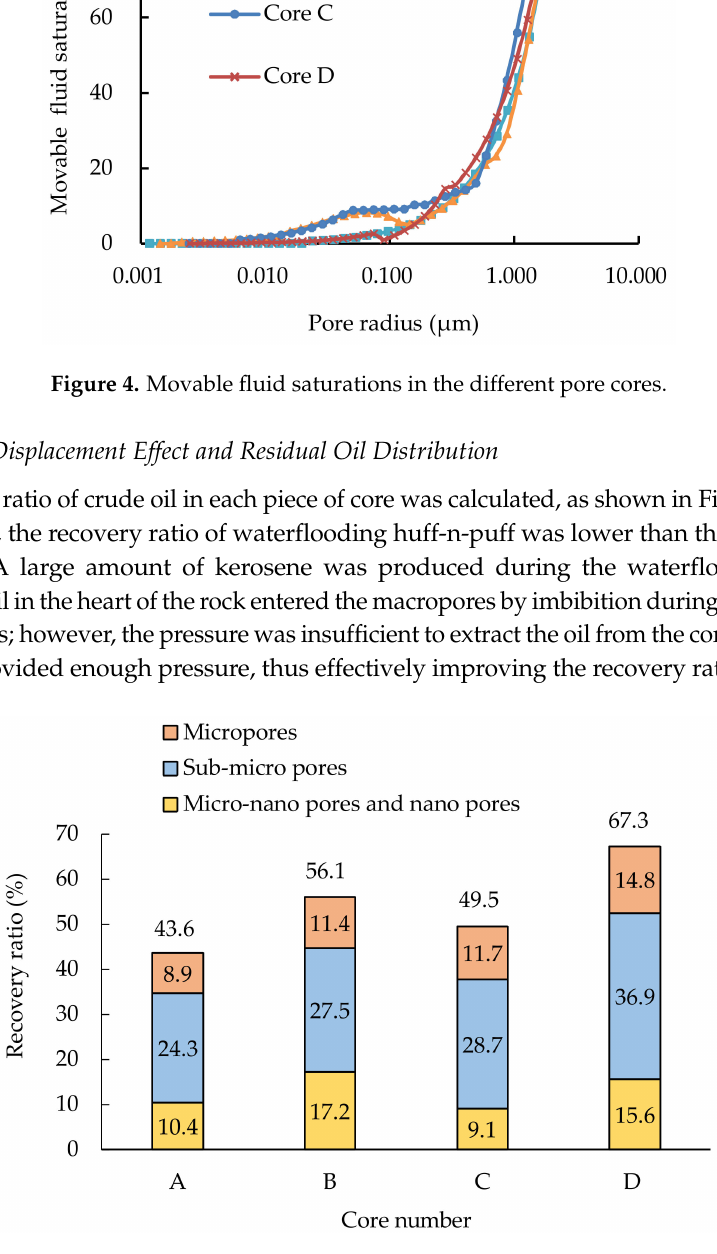
Figure 5. Recovery ratio for the cores and their different